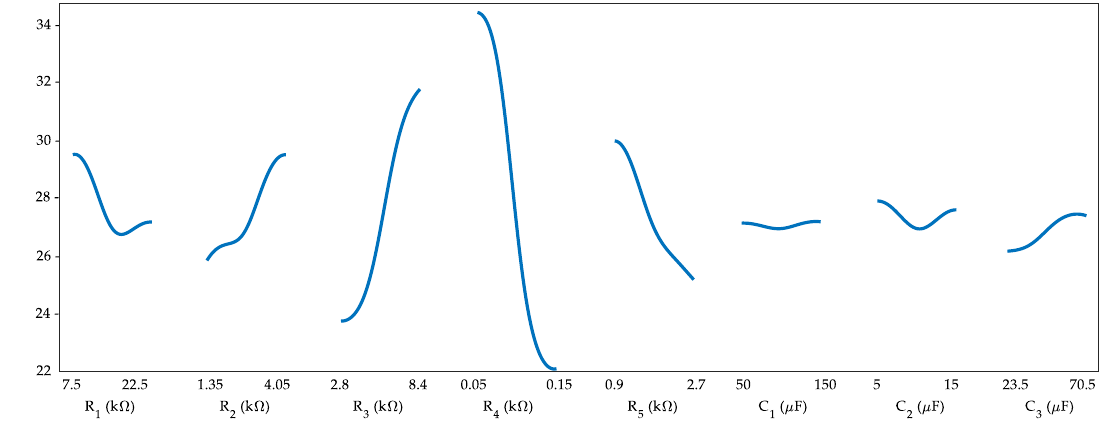
Figure 17. Main effects plot for Av using the FIS.